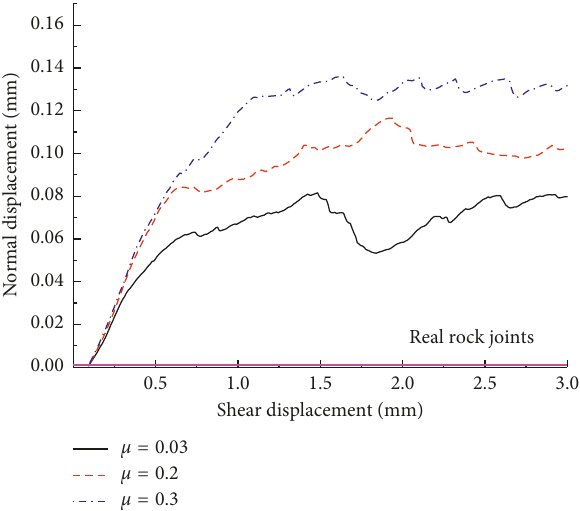
Figure 4: Shear and normal displacement